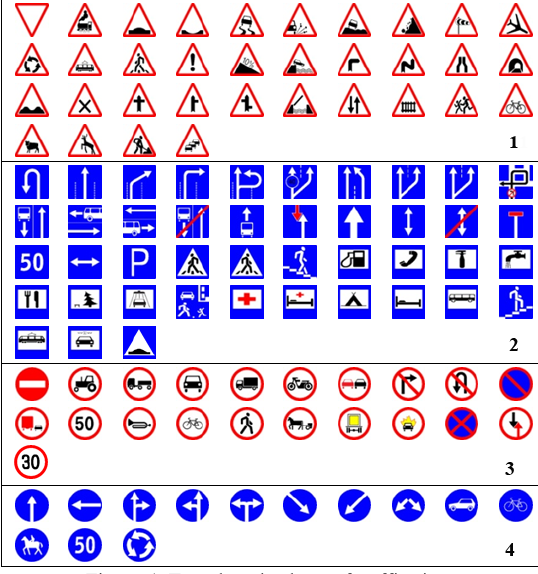
Figure 4. Template database of traffic